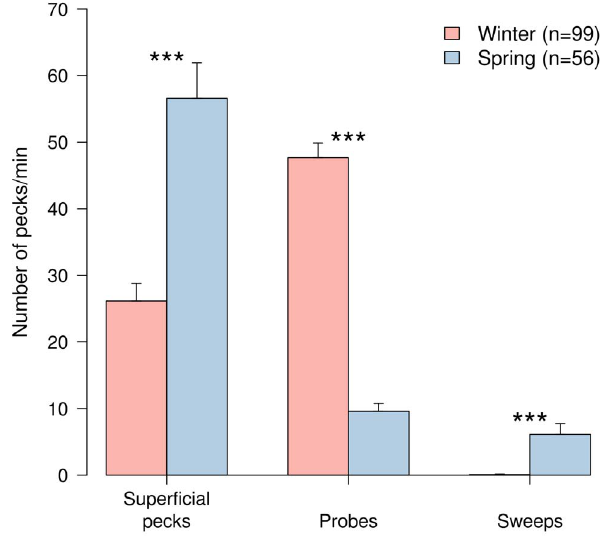
Figure 2. Mean rate of superficial pecks, probes and sweeps of foraging dunlins in winter and spring. Values represent mean 6 SE. Differences between seasons were tested with Mann-Whitney test (*** p , 0.001).